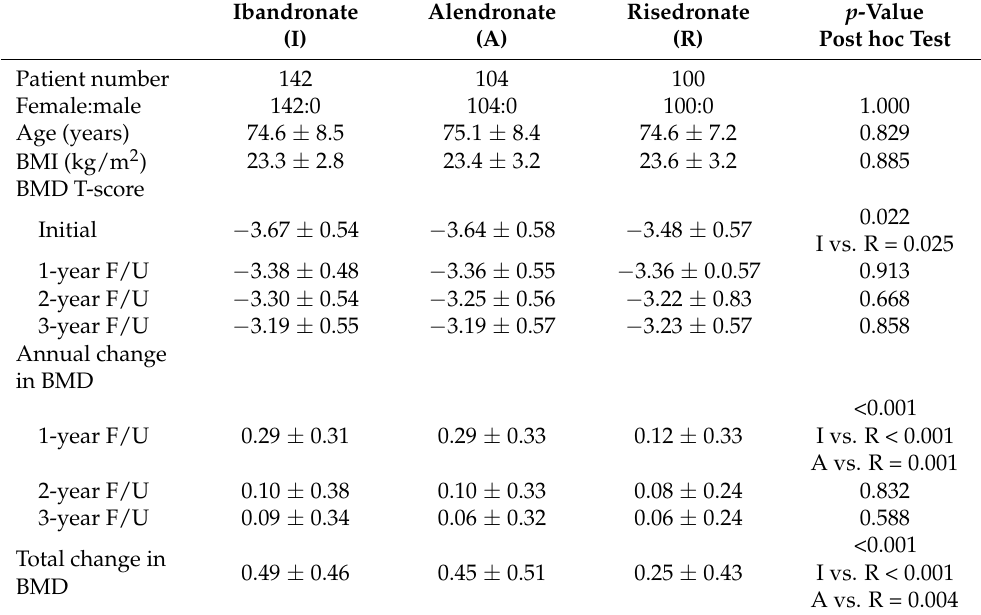
Table 2. Annual BMD T-scores and changes in BMD according to the three different types of BP.